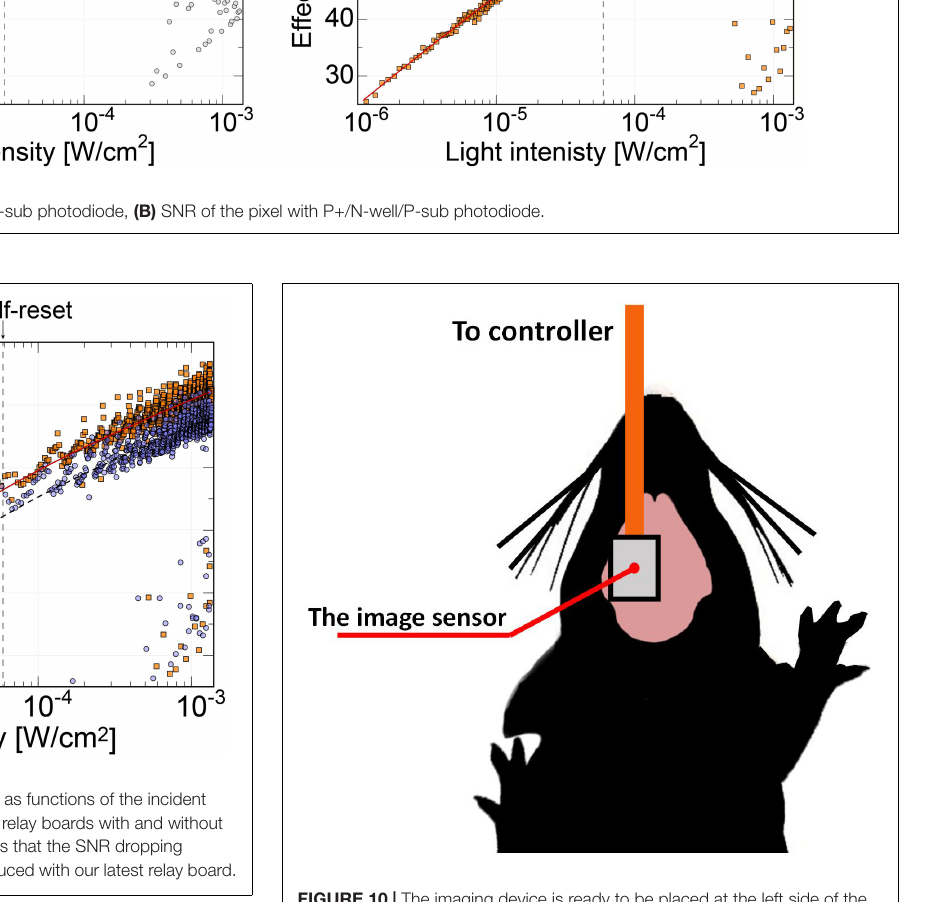
FIGURE 10 | The imaging device is ready to be placed at the left side of the brain on the somatosensory cortex area, while the stimulation was performed on the opposite